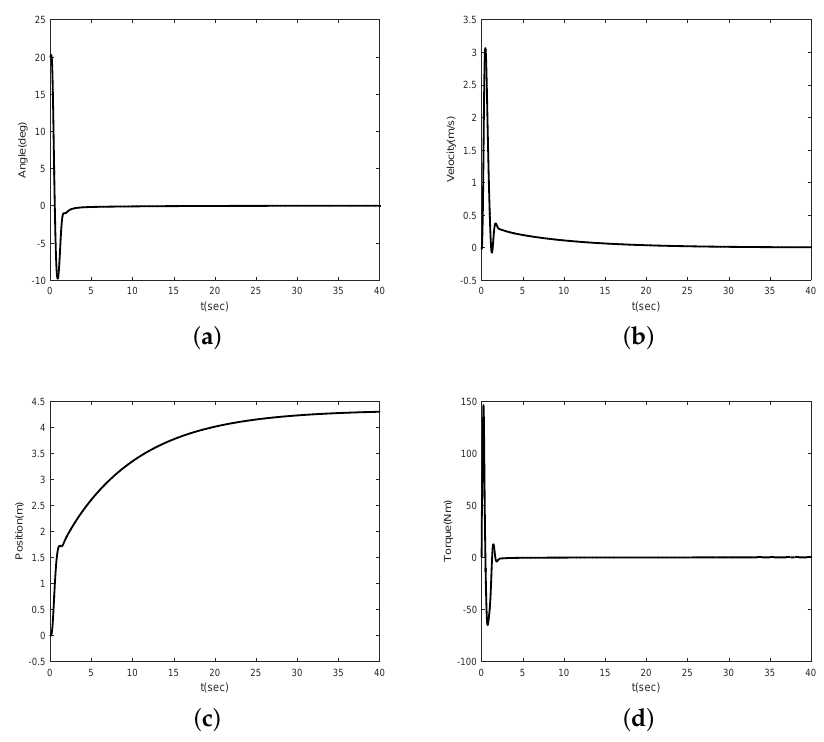
Figure 2. Simulation result for θ ( 0 ) = 20 ◦ : ( a ) angle θ ; ( b ) linear velocity v ; ( c ) position x ; ( d ) torque τ .